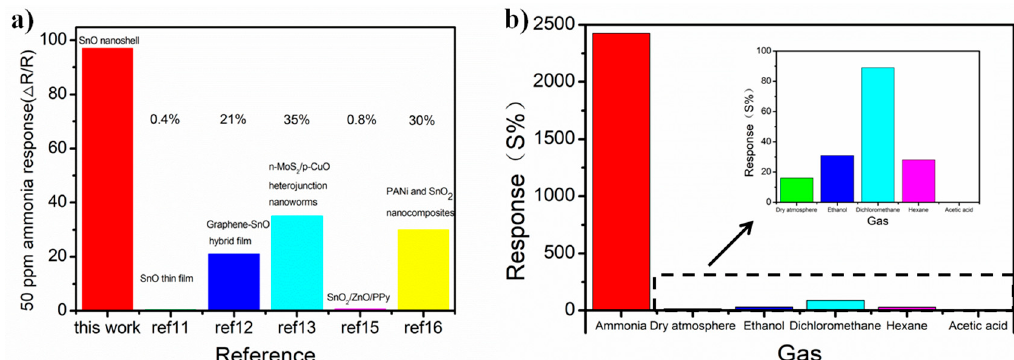
Figure 5. Response of as fabricated sensors compared with other work and in different gases. ( a ) Response of ammonia sensors compared with other work based on metal oxides. (The result was normalized as S = (R a − R g )/R a × 100) ( b ) Response of as fabricated sensors in different gas environments.